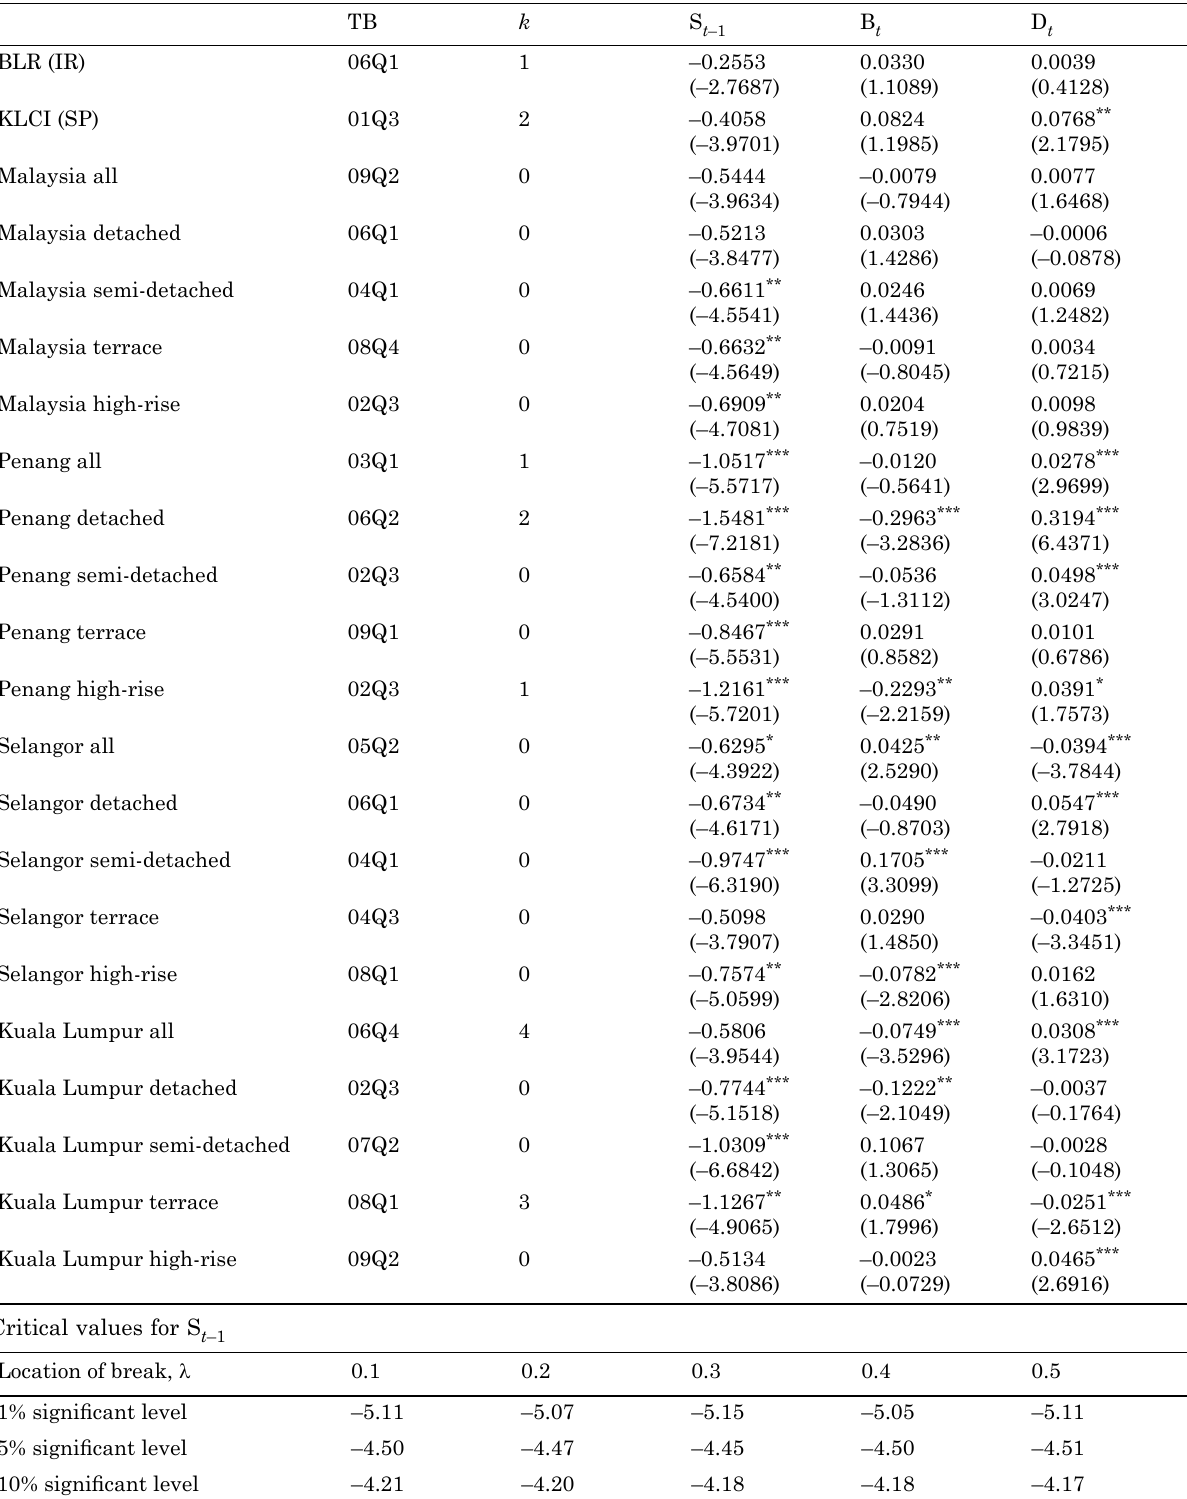
Table 2. LM unit root test with one structural break in the intercept and trend (Model